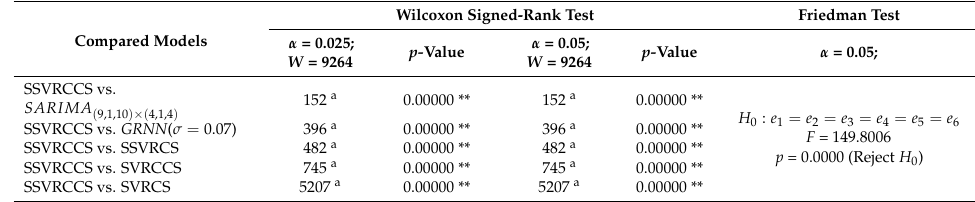
Table 8. Results of Wilcoxon signed-rank test and Friedman test for Example